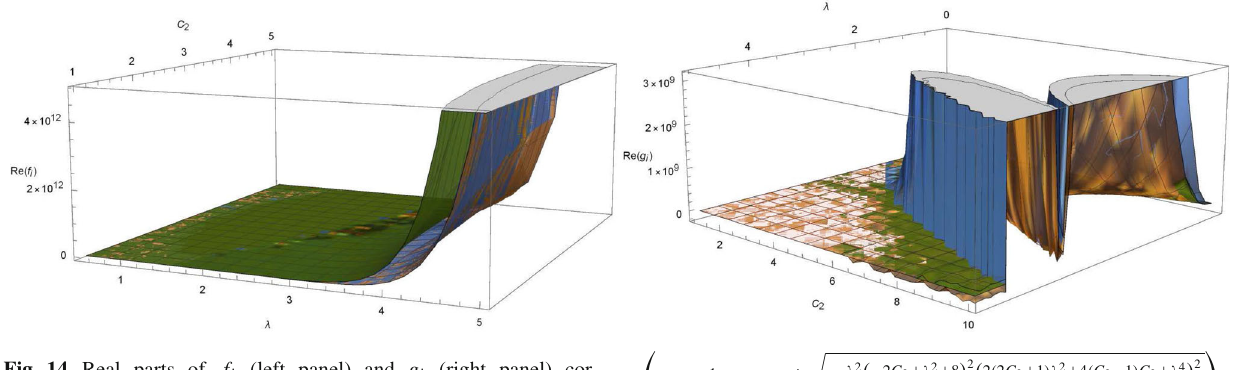
Fig. 14 Real parts of f i (left panel) and g i (right panel) cor- responding to the equilibrium points Q 30 : (Σ, A , u ,w) = 0